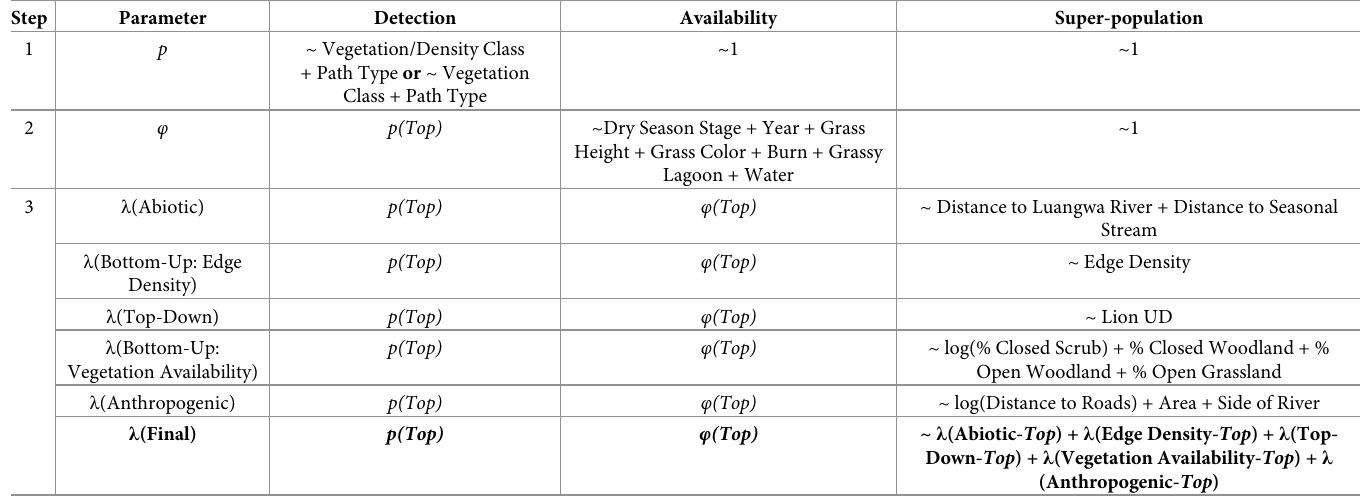
Table 2. Full models of detection ( p ), availability ( φ ), and group super-population ( λ ) to illustrate the model refinement process. We used AIC model selection to evaluate these models and their subsets for each species and used the best supported models for each parameter to build the final model set. For continuous covariates we considered linear, log, and second-order polynomial relationships. For super-population, we identified the best performing model for each covariate type, and then created a final candidate model list using all combinations of those parametrizations. We split bottom-up abundance model selection into vegetation availability (proportion of vegetation classifications around segments) and edge density model sets to reduce computation